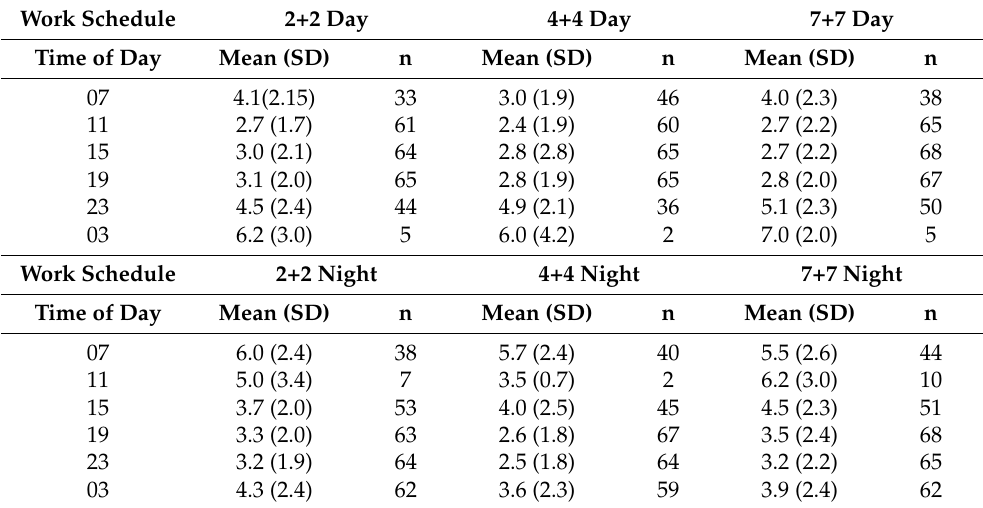
Figure 1. Distribution of napping in % of participants in the three different work schedules. Schedule 2+2 refers to 2 night shifts followed by 2 recovery days. Schedule 4+4 refers to 4 night shifts followed by 4 recovery days. Schedule 7+7 refers to 7 night shifts followed by 7 recovery days. Night shifts are shown in black and recovery days in grey. Table 3. Mean KSS and number of observations for the different work